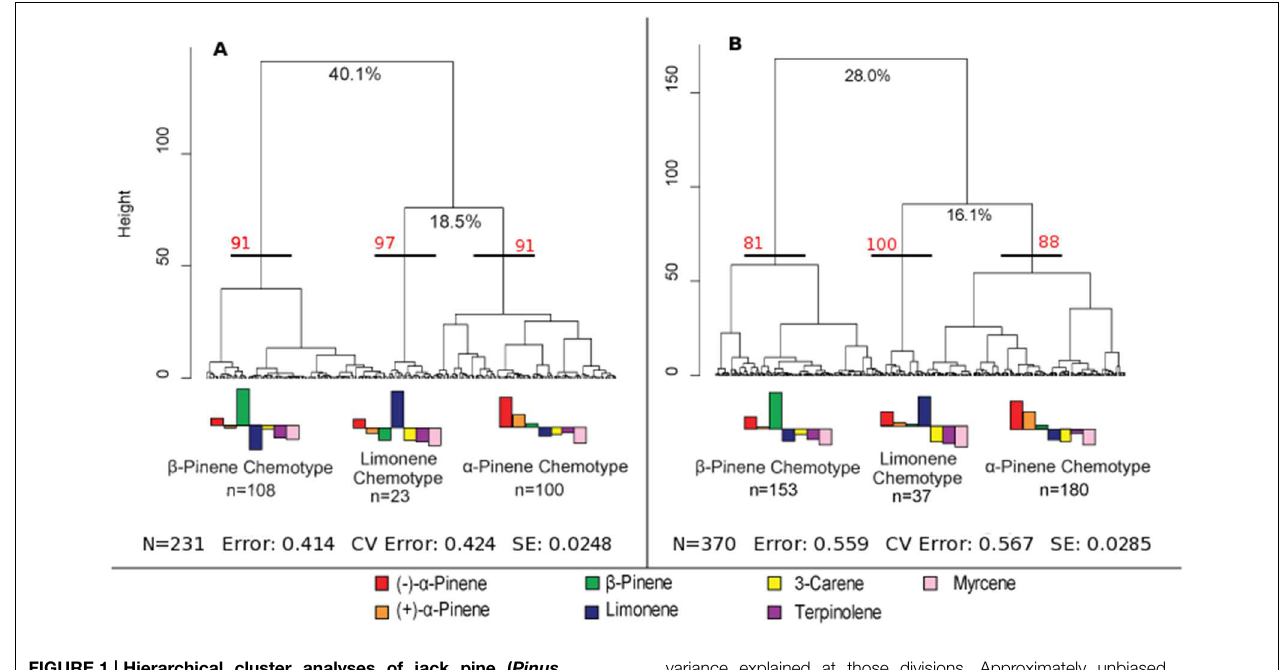
FIGURE 1 | Hierarchical cluster analyses of jack pine ( Pinus banksiana ) monoterpene proportions in (A) natural stands across eastern Canada and northeastern U.S. and (B) provenance stands representing jack pine populations from Alberta to the Atlantic coast. The three broadest divisions of each cluster analysis were used to define chemotypes. The percent values at the first two divisions of each cluster analysis represent the